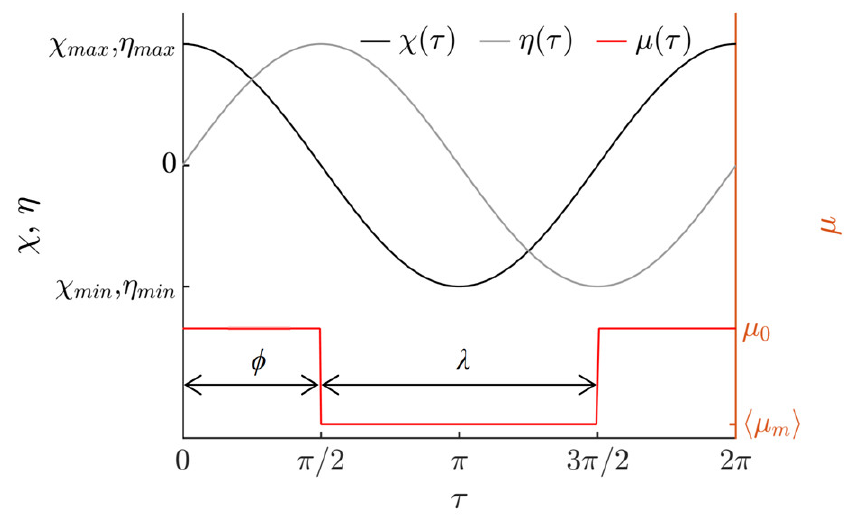
Figure 2. Principle of dynamic dry friction control.